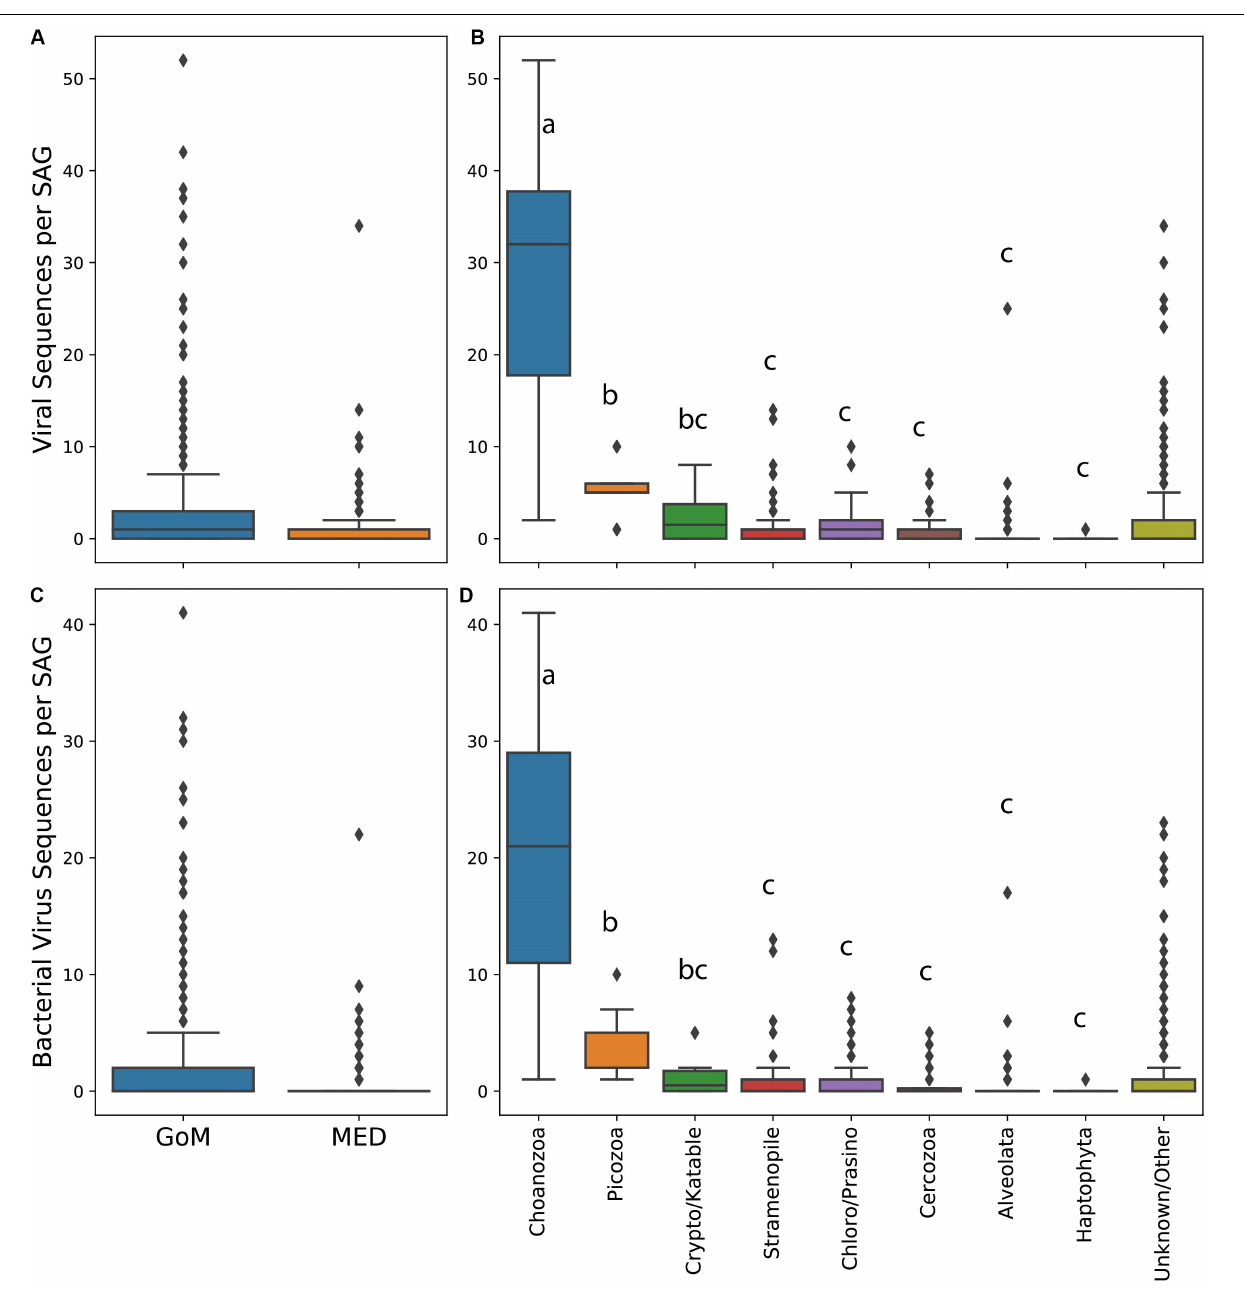
( Figure 2 ) indicate that non-specific attachment and viral co- sorting cannot fully explain the observed distribution of